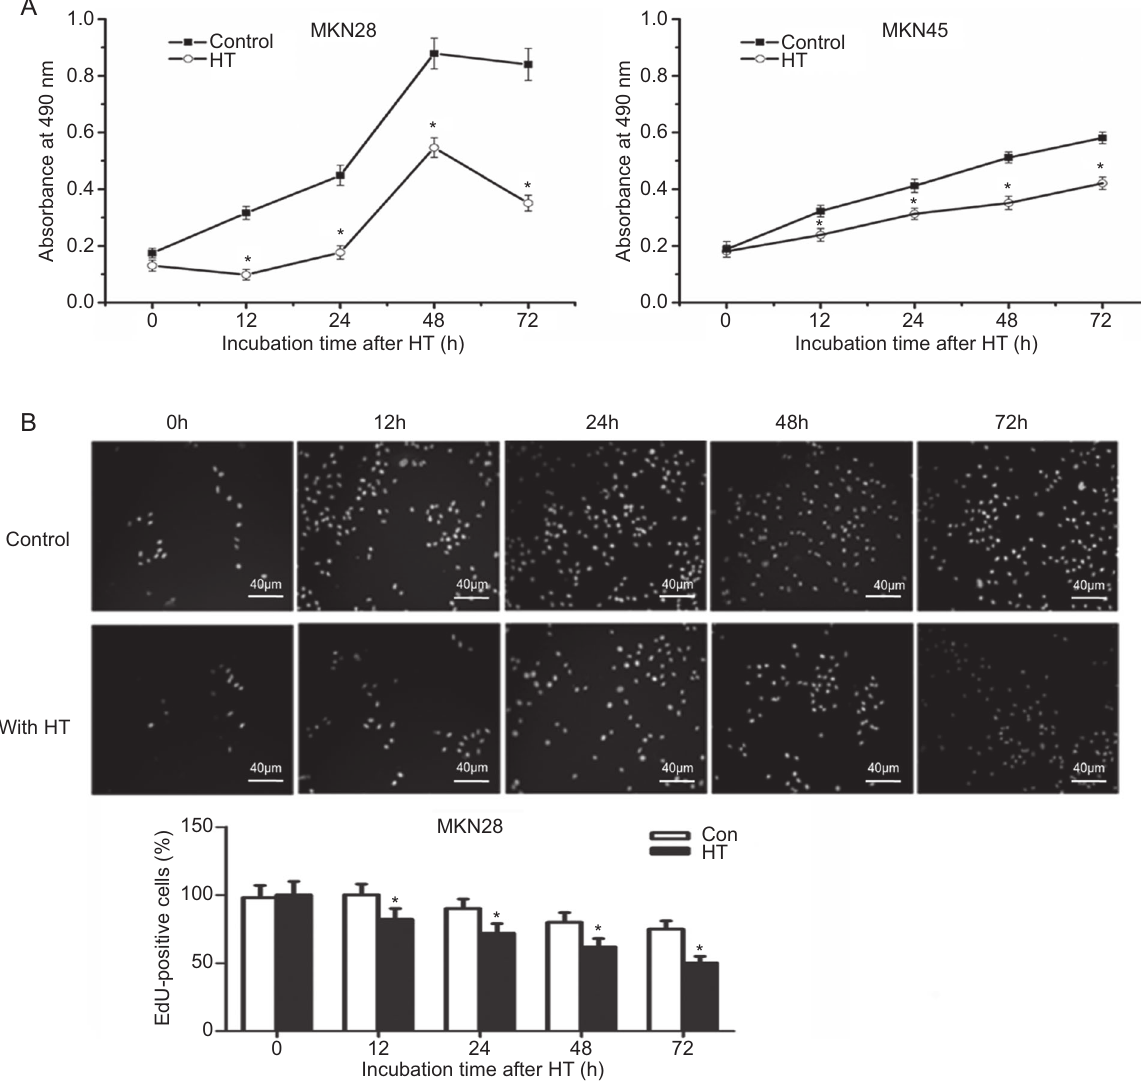
Figure 1. Hyperthermia (HT) inhibited cell viability and cell proliferation in gastric cancer cells. MKN28 and MKN45 cells were treated with HT (42 6 C for 1 h) and gastric cancer cells cultured at 37 6 C were used as control (Con). A , Cell growth curve. Cell viability was determined by the MTT assay at the indicated times after 1 h of HT. B, Cell proliferation of MKN28 cells after 1 h of hyperthermia. The cell proliferation rate was detected by EdU incorporation for up to 72 h after HT. Scale bars = 40 m m. Results are reported as means ± SD for 3 independent experiments. *P , 0.05 compared to control (Dunnett